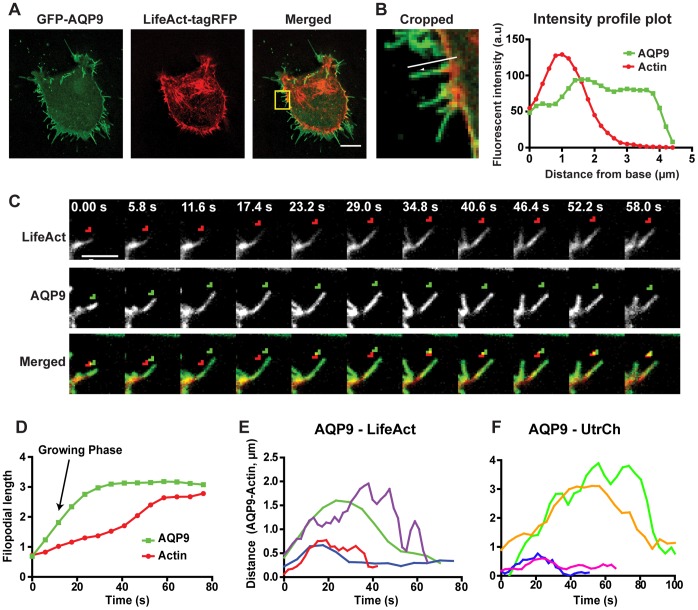
Interplay of filopodial actin and AQP9 reveals temporal changes in their relative distribution.(A) Representative confocal images of a HEK-293 cell stably overexpressing GFP-AQP9 and transfected with the actin-filament labeling probe tagRFP-LifeAct. Intensities have been adjusted linearly to visualize the relative distribution of both fluorophores. Scalebar 10 µm. (B, left panel) Enlarged area of the yellow box in A. Arrow shows the direction and filopodia subjected for measurement in the right panel. (B, right panel) Relative intensity profile plot of the filopodia presented in the left panel. The data is presented as a moving average of 3 adjacent values. (C) A cropped confocal time-lapse montage of tagRFP-LifeAct (upper panel, red in lower panel) and GFP-AQP9 (middle panel and green in lower panel) distribution during filopodial growth. To highlight differences in spatial distribution, the tip of the actin filaments were labeled with a red arrow and the tip of the AQP9 fluorescent intensity is labeled with a green arrow. Linear intensities have been adjusted to visualize the relative distribution of both fluorophores. (D) A representative image showing the analysis of the relative distribution of GFP-AQP9 and tagRFP-LifeAct along the length of a filopodium during growth. The data is presented as a moving average of 3 adjacent values. (E) Illustration of the space between the filopodial tip in the GFP channel versus the RFP channel in four filopodia imaged in HEK-293 cell overexpressing both GFP-AQP9 and tagRFP-LifeAct. The initial point represents the initiation of growth, and the terminal point represents the end of growth. Each colored line represents the distance between AQP9 and actin in individual filopodia. The data is presented as a moving average of 3 adjacent values.(F) Similar analysis as in E, using mRFP-UtrCH showing the gap between AQP9 fluorescence and actin filaments was not due to interference of polymerization or loss of binding by the actin labeling probe in E.